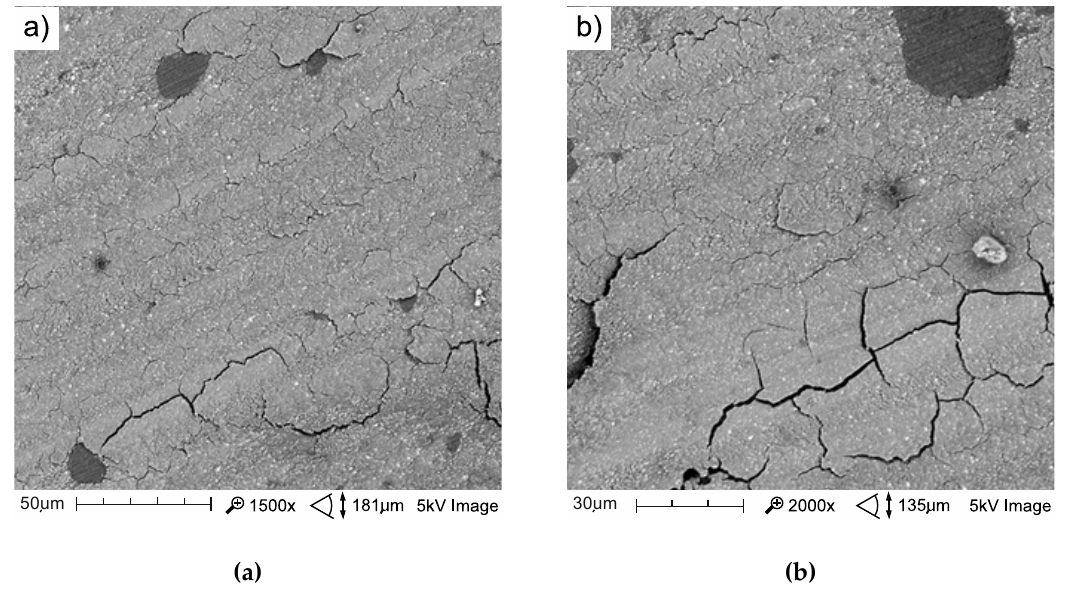
Figure 14. SEM image of a wear track of the composite Ex-nano (G) with aging only in AS at 37 ◦ C ( a ) and after 10 4 TCs ( b ).